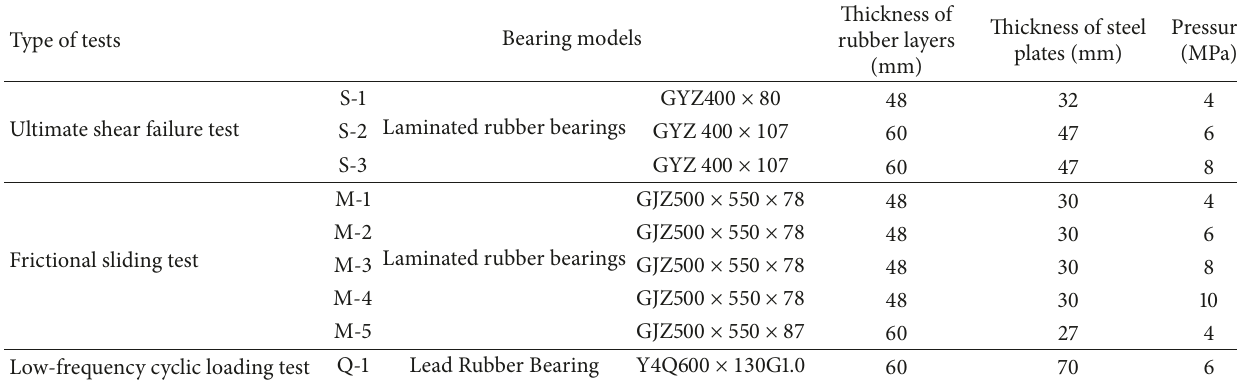
Table 1: Scheme of the bearing test.